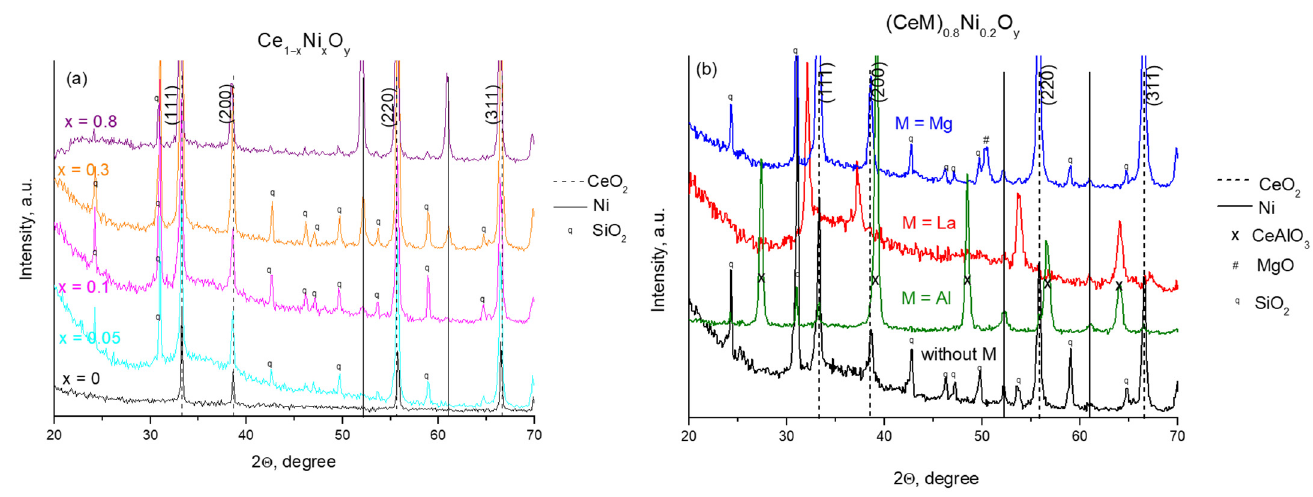
Figure 24. XRD patterns for spent (CeM) 1 − x Ni x O y (M = Al, La, Mg) samples: effect of Ni molar fraction ( a ) and M type ( b ). ( b )—M/Ce molar ratio is equal to 1. Reaction conditions: 800 ◦ C, 24 h.